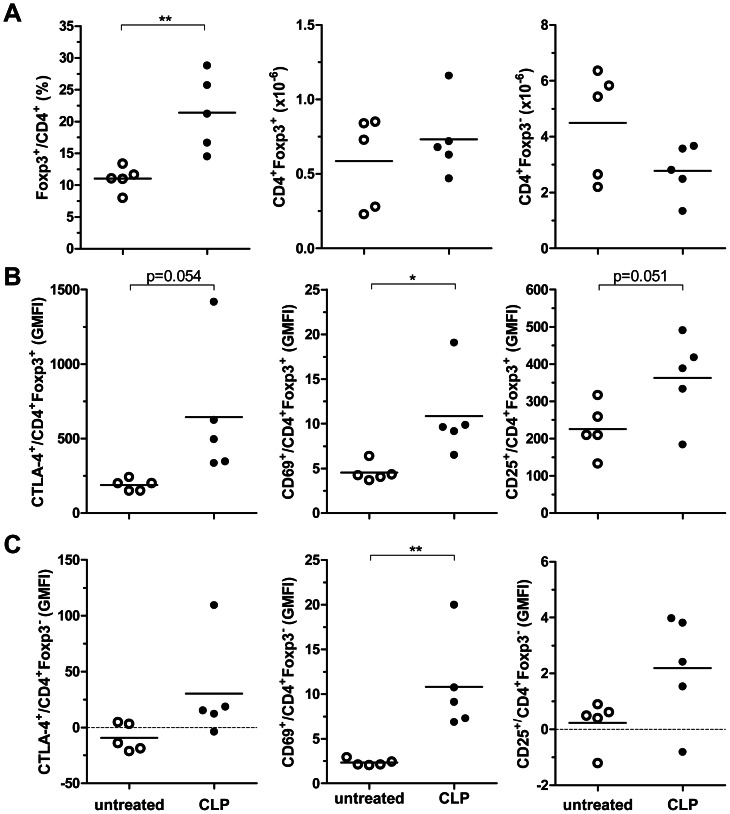
CLP rapidly activated CD4+T cells and increased the percentage of the Foxp3+ Treg subpopulation.DEREG mice were subjected to 18G CLP or left untreated. Twenty-four hours later the percentage of Foxp3+ cells in the CD4+ T cell subpopulation and the absolute numbers of CD4+Foxp3+ and CD4+Foxp3− cells of the spleen were determined (A). In addition, the expression of the activation markers CTLA4, CD69, and CD25 on Foxp3+ Tregs (B) and Foxp3− Teffs (C) was assessed (GMFI, geometric mean fluorescence intensity). The means are indicated. n = 5 mice/group. * p<0.05; ** p<0.01.